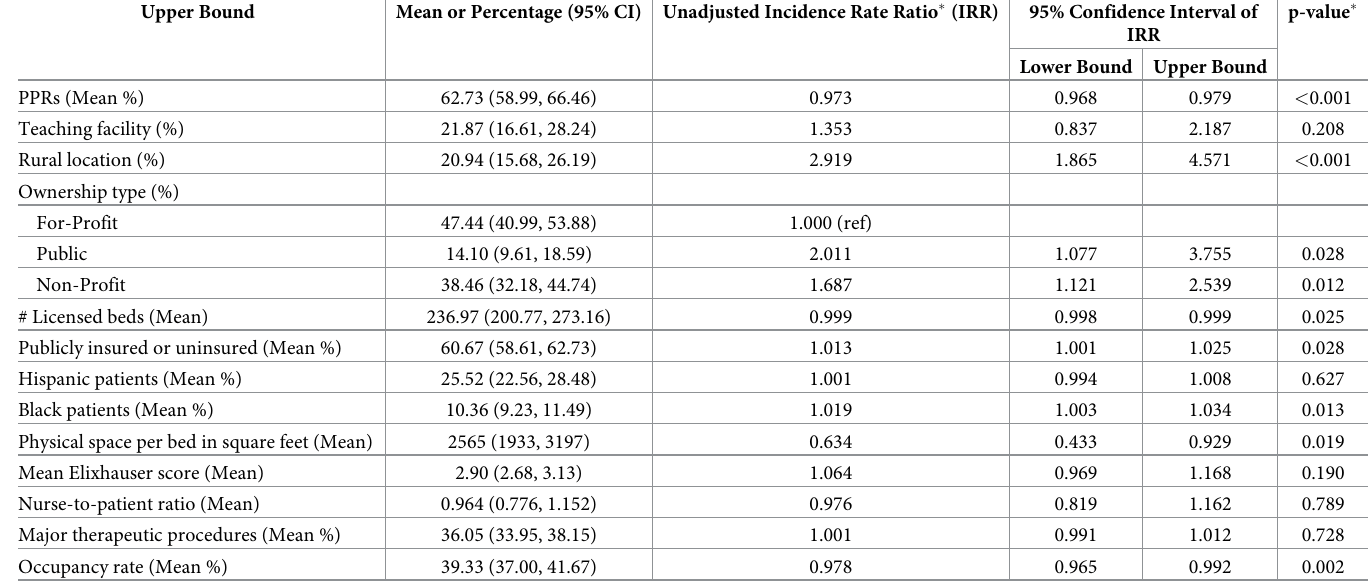
Table 1. Characteristics of 340 US hospitals and unadjusted associations between hospital characteristics and rates of methicillin-resistant Staphylococcus aureus (HA-MRSA) infection for discharges occurring between September 2015 and August 2016.